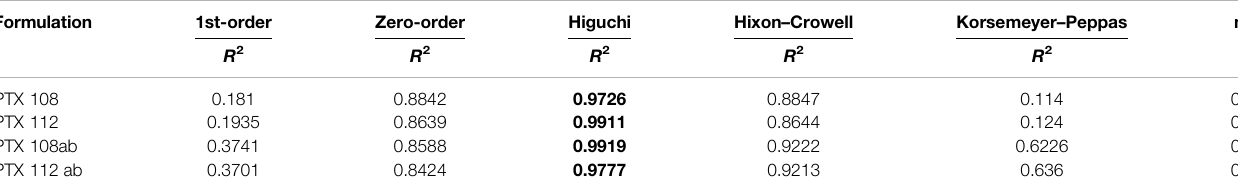
TABLE 6 | In vitro drug release kinetics of the optimized nanoformulations. Bold values are drug release from nanoformulations best fi ts to Higuchi model. Formulation